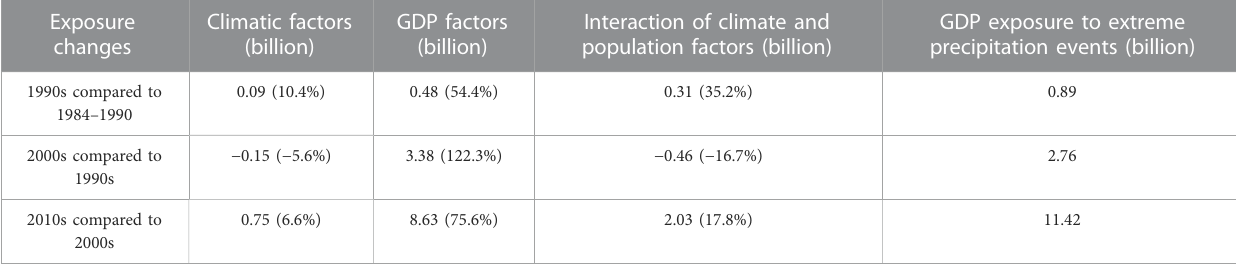
TABLE 2 Analysis of factors in fl uencing change in GDP exposure change to extreme precipitation events across the Poyang Lake Basin. Exposure